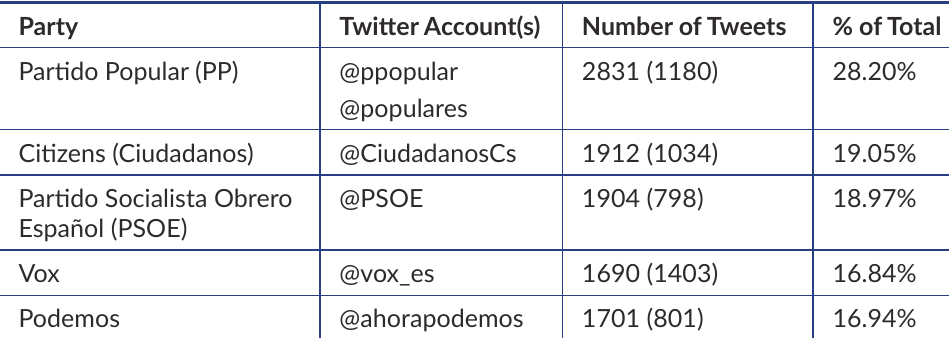
Table 1: Total Number of Tweets and Retweets Generated by Account. Obs.: The figure in parentheses denotes the total number of original tweets originating from each party’s account, excluding retweets. On March 8, 2019, International Women’s Day, the PP changed its official Twitter handle from @ppopular to @populares. This study considers the data from both accounts as a single data